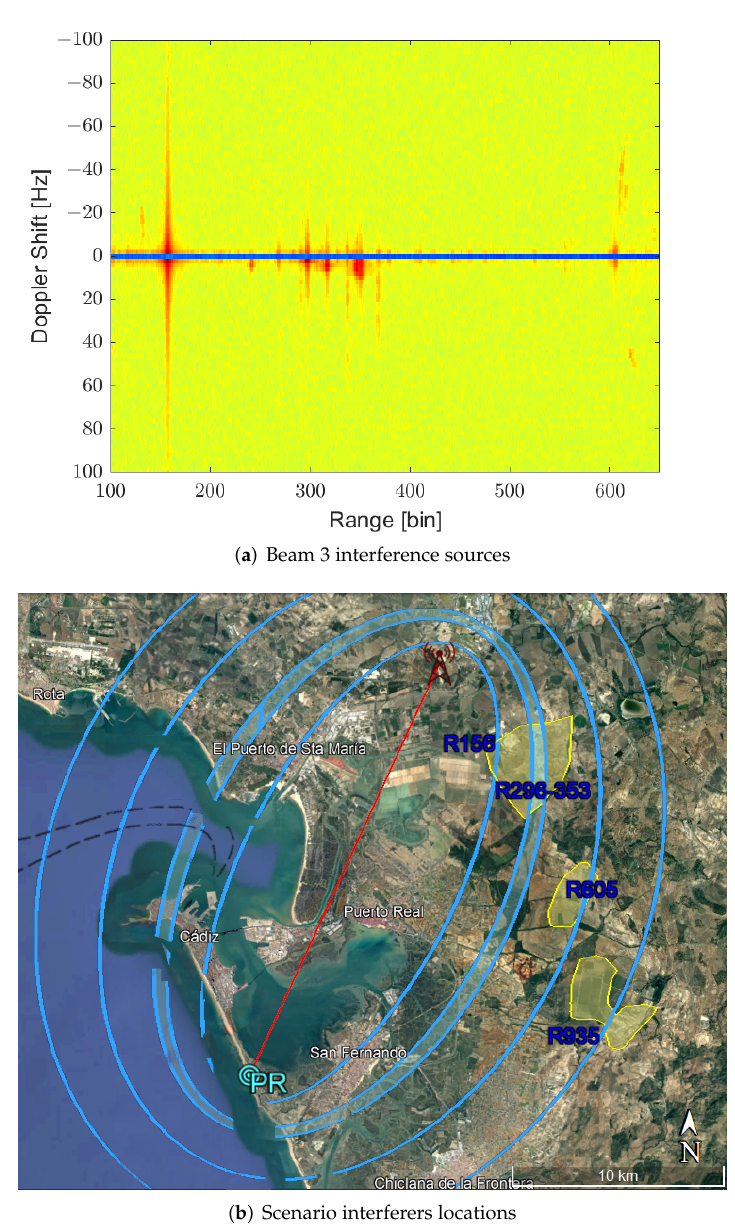
Figure 7. Zoom of cumulative of maxima of RD in beam 3 to appreciate the interference sources and location of these interferers ranges in the